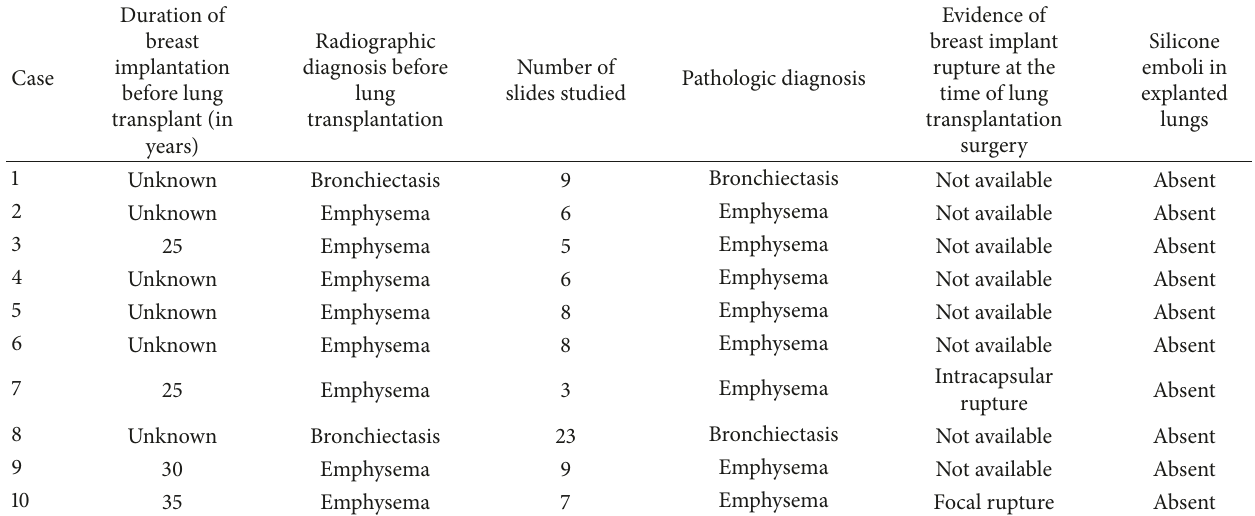
Table 2: Radiographic and pathologic findings of the explanted